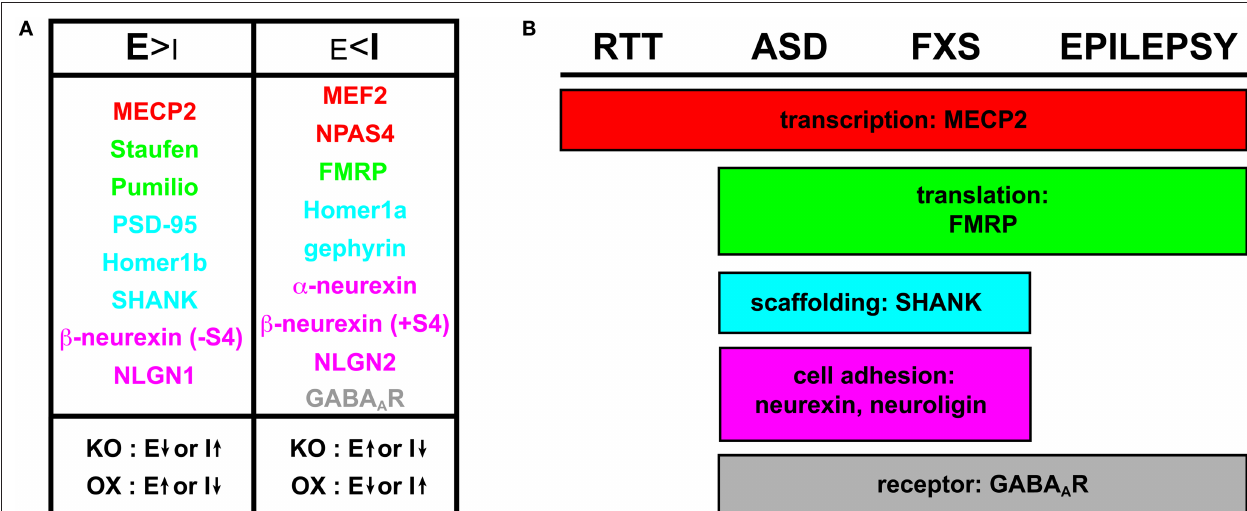
formation is favored ( E < I ) when KO yields elevated E or depressed I , and OX yields depressed E or elevated I . (B) Regulators implicated in neurodevelopmental disease states illustrating the molecular overlap in RTT, ASD, FXS and epilepsy. The list includes players based on clinically implicated genetic influence and/or identification in neurodevelopmental model systems. As indicated in Figure 1 , robust inter-relationships suggest that several of these players are likely more widespread in their involvement, especially pertaining to